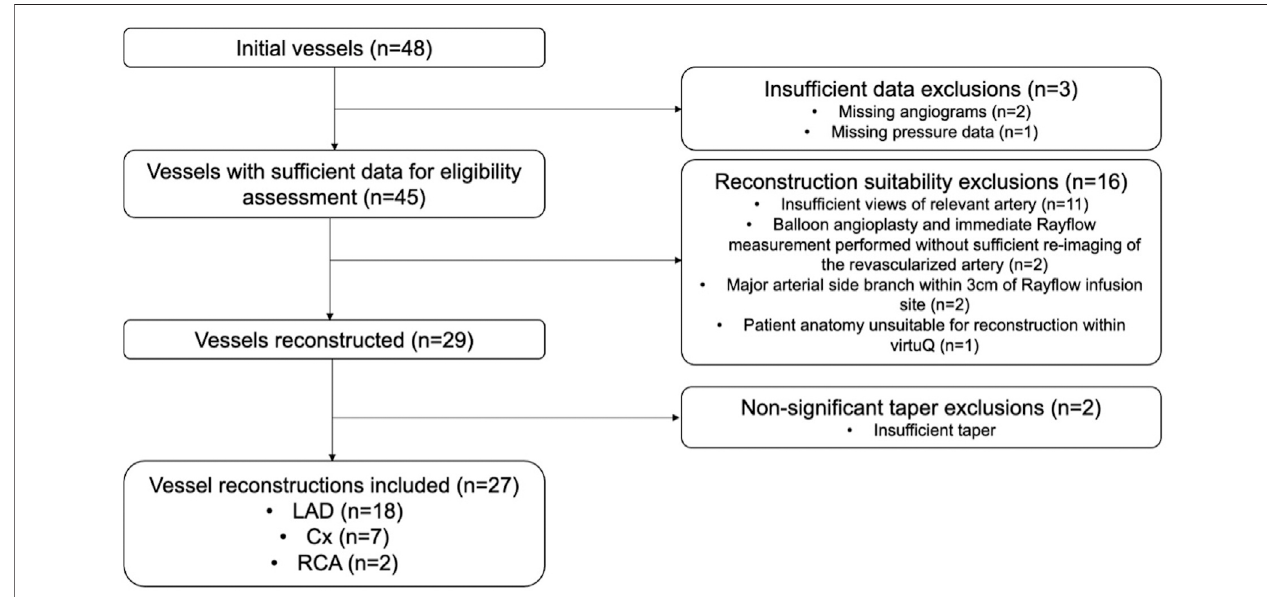
FIGURE 1 | Flow diagram showing case exclusions. Cx, Left circum fl ex artery; LAD, Left anterior descending artery; RCA, Right coronary artery.